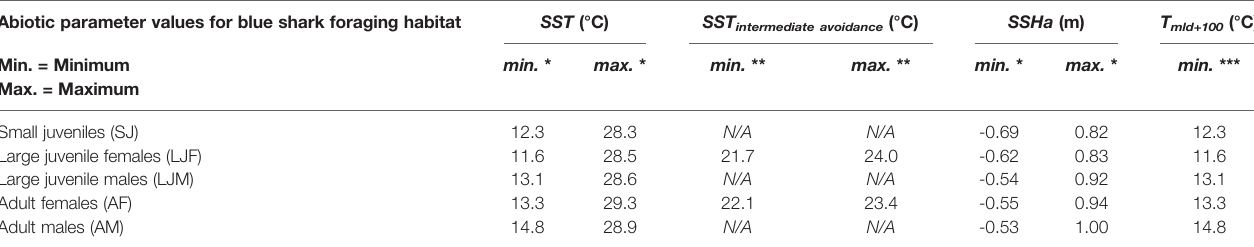
TABLE 2 | Calibration parameters for the abiotic variables of the blue shark foraging habitat model. Abiotic parameter values for blue shark foraging habitat SST (°C) SST intermediate avoidance (°C) SSHa (m) T mld+100 (°C) Min. = Minimum min. * max. *